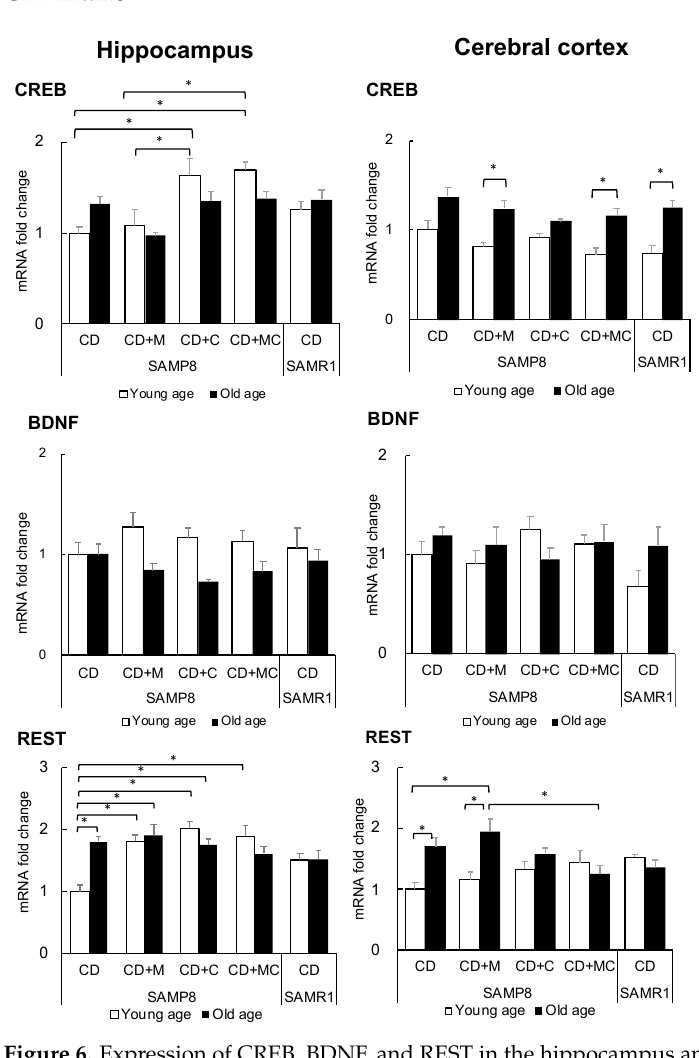
Figure 6. Expression of CREB, BDNF, and REST in the hippocampus and cerebral cortex. Each value represents the mean ± SEM ( n = 6). Asterisks denote significant differences (*, p < 0.05, Fisher’s least significant difference test).